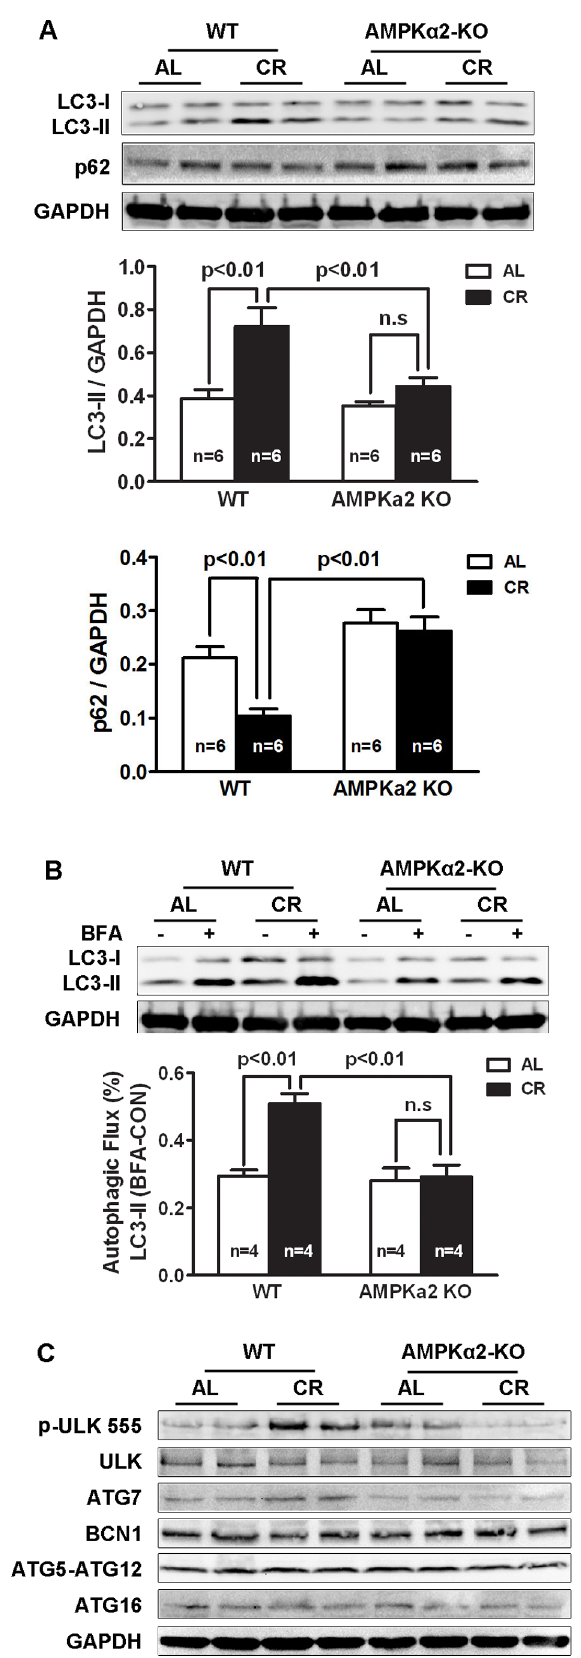
Figure 4. AMPK a 2 is essential for the CR-induced autophagy in the heart. A. CR increased LC3-II levels and decreased p62 levels in WT mice, but not in AMPK a 2 KO mice. B. CR increased cardiac autophagic flux in WT mice, but not in AMPK a 2 KO mice, as shown by the difference of LC3-II protein levels in the absence and presence of bafilomycin A1 (BFA, 3 m mole/kg), an inhibitor of autophagic degradation. BFA was delivered by i.p. injection 30 minutes before animals were sacrificed. C. CR induced the phosphorylation of ULK1 at ser555 in WT mice, but not in AMPK a 2 KO mice. Data in A and B were expressed as mean 6 SE and analyzed by two-way ANOVA. Sample sizes were indicated in the bar